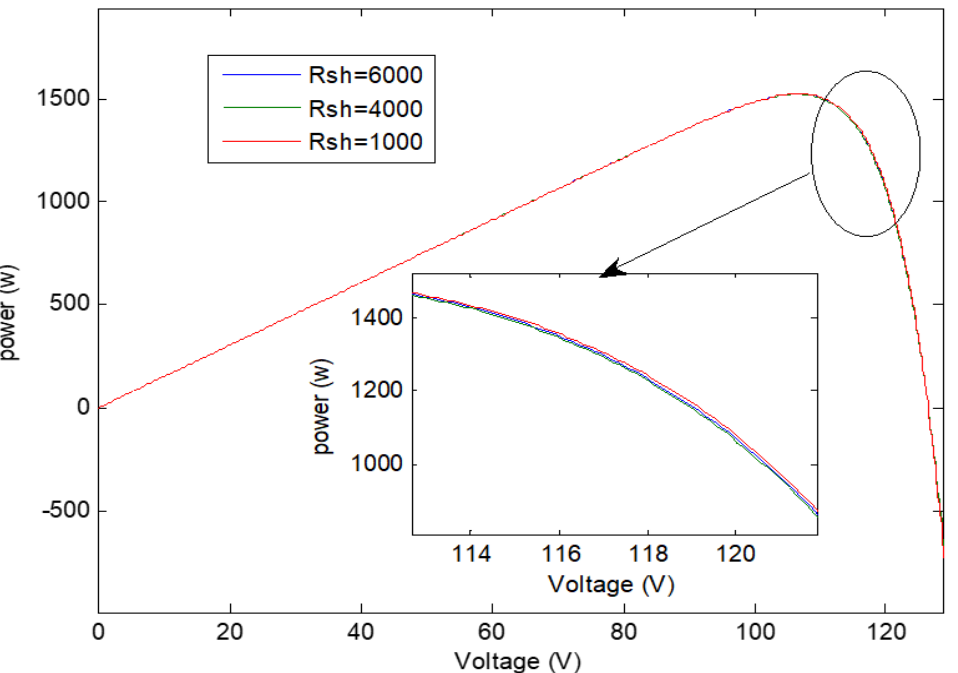
Figure 9. Effect of variation of PV cell parallel resistance on the power output of PV array.